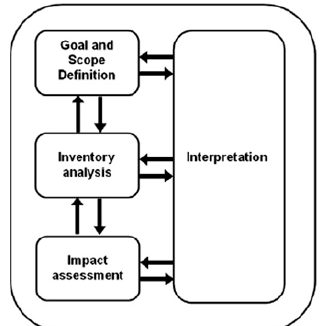
Figure 3. Outline of Life Cycle Assessment (LCA) according to ISO 14040:2006 [49].